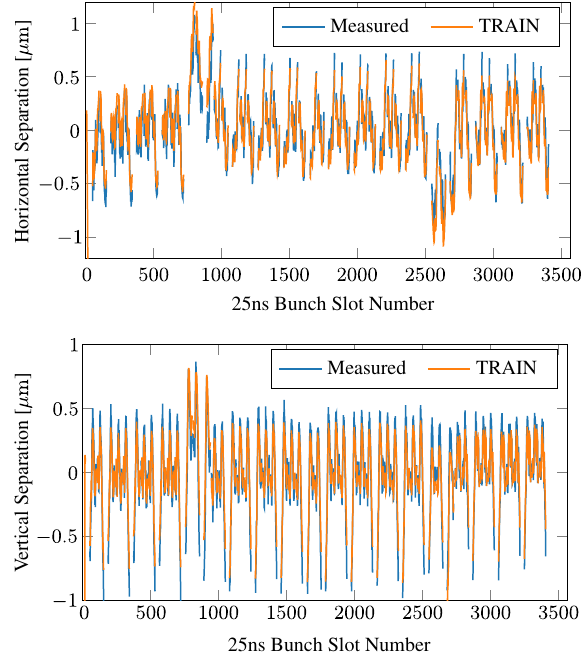
FIG. 17. The bunch-by-bunch orbit separations at the CMS experiment for all bunches colliding there (fill 5976). Note that the trains missing collisions in ALICE and LHCb have different separations (in particular in the horizontal